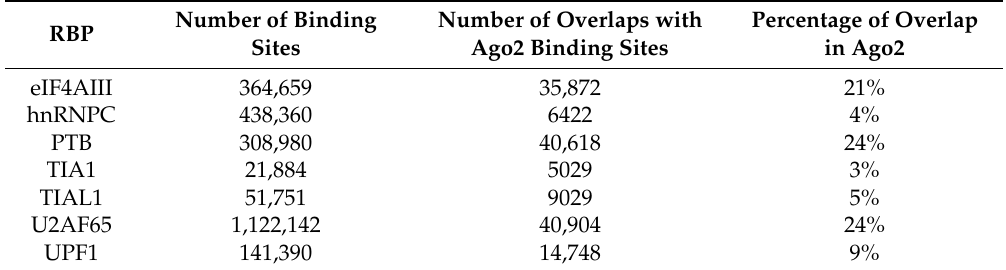
Table 1. Identification of overlapping RBP and Ago2 binding